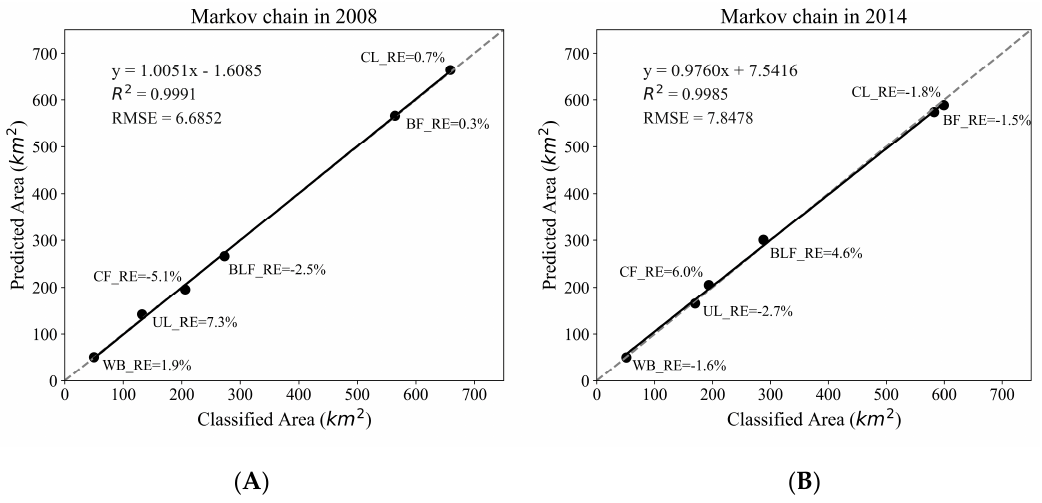
Figure 6. The error of Markov chain ( A ) in 2008 and ( B ) in 2014. (RE is the relative error between the simulated area of each land use and the actual classification area).